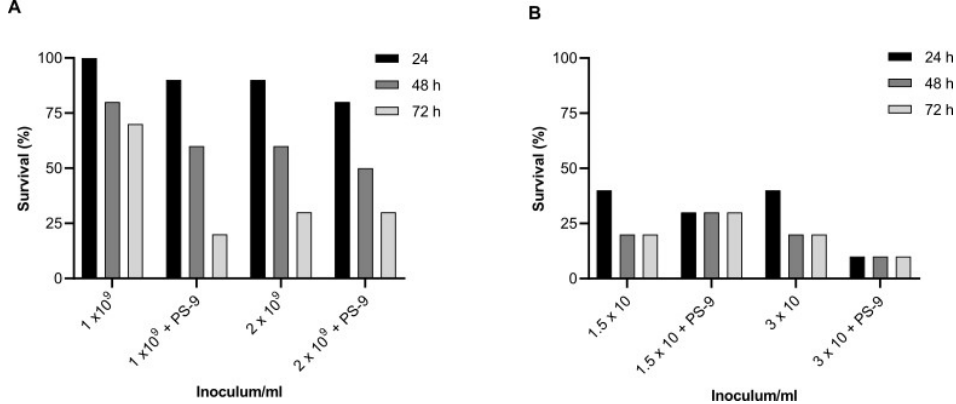
Figure 7. Survival of G. mellonella ( n = 10) larvae infected with ( A ) S. aureus and ( B ) P. aeruginosa , with and without PS9 treatment.